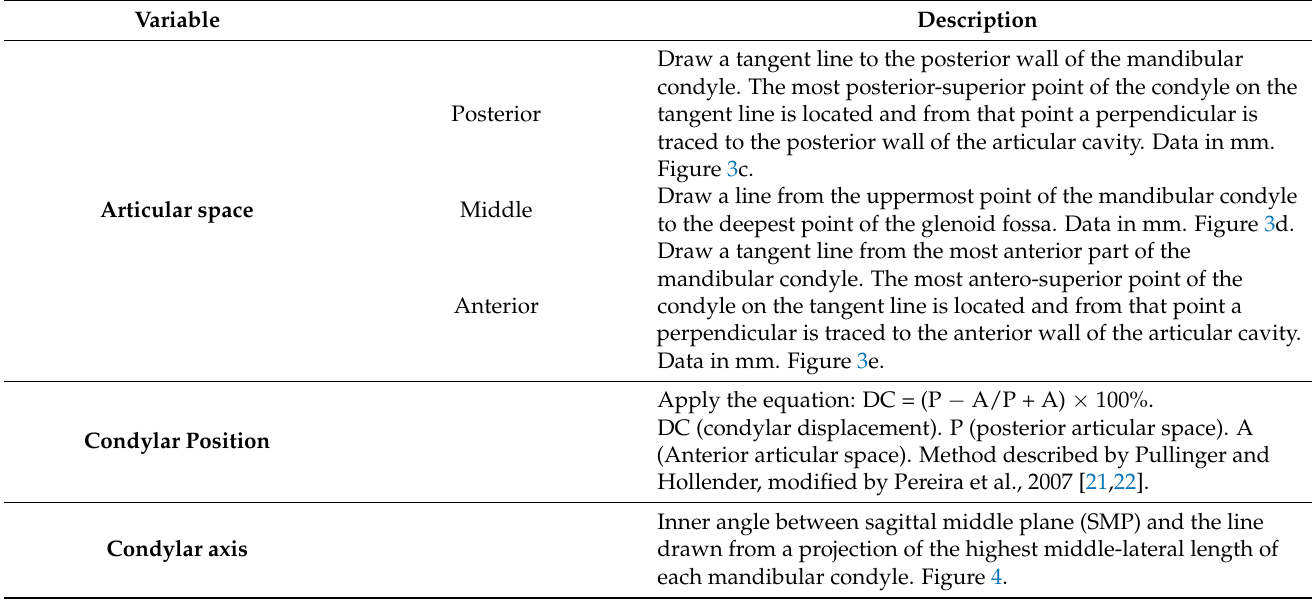
Table 1. Description of the variables measured in CT and CBCT.